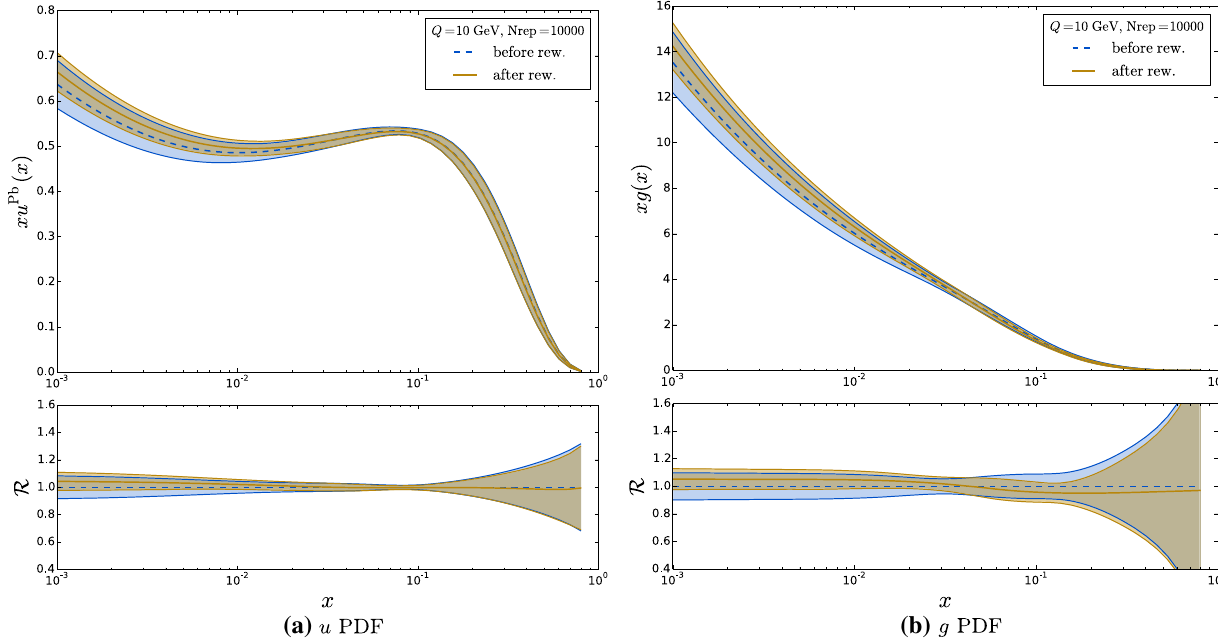
Fig. 22 Comparison of PDFs at a scale of Q = 10GeV before and after the reweighting procedure using asymmetries measured by CMS [4]. The lower plots show the ratio compared to the central (average) distribution before the